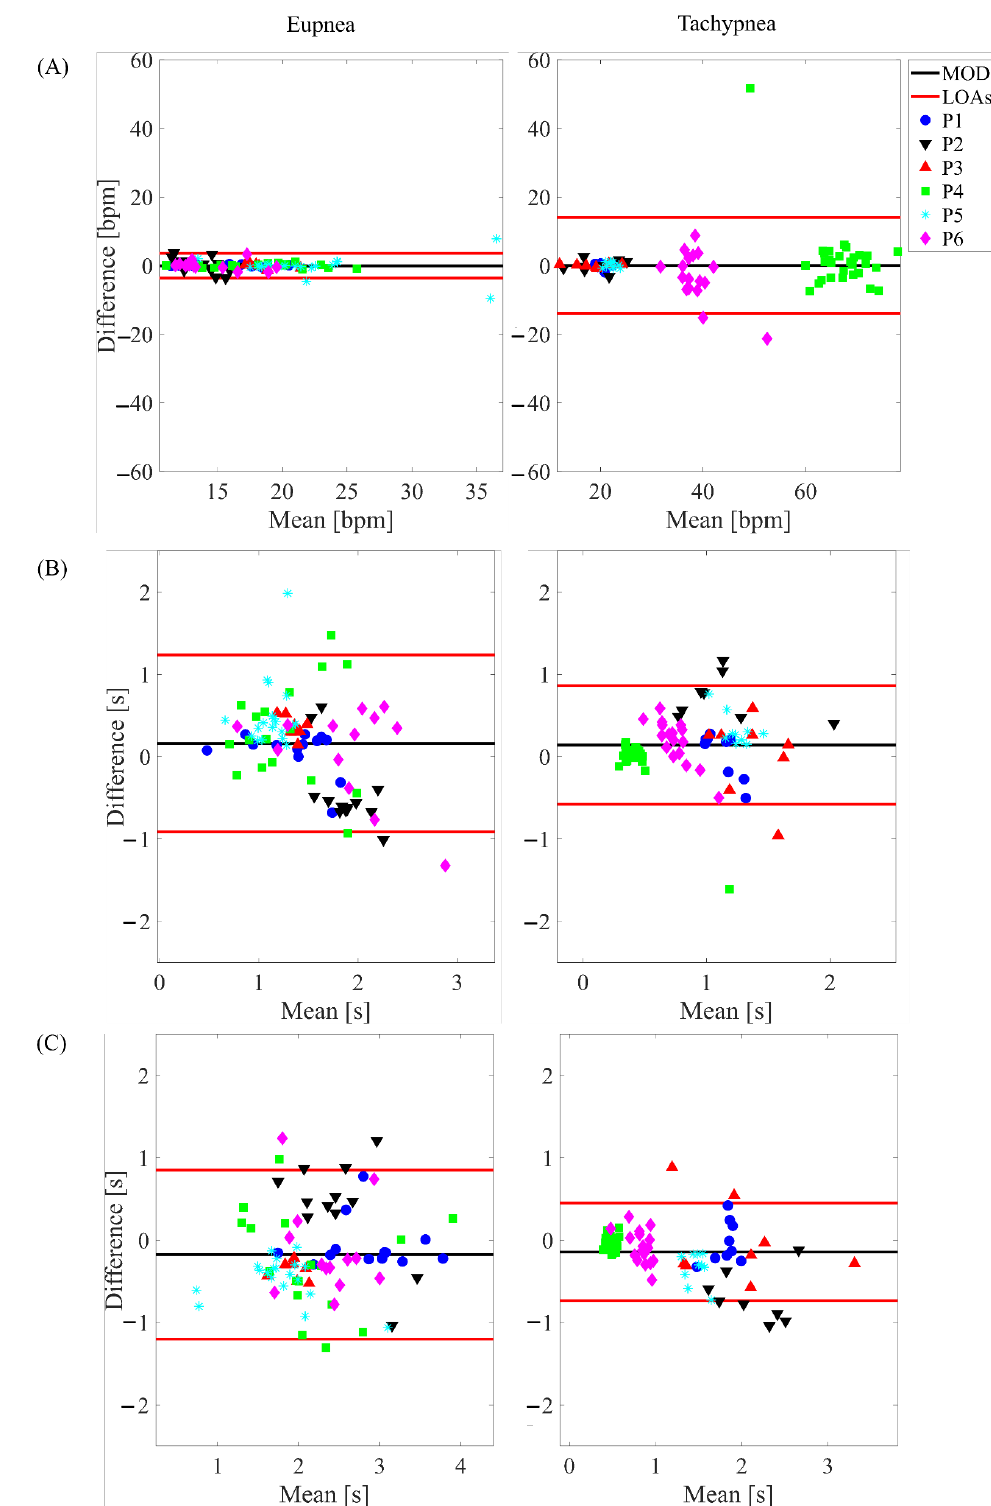
Figure 8. Bland-Altman plots depicting the estimated ( A ) f r , ( B ) t i and ( C ) t e on the respiratory signal retrieved from the affected side in eupnea and tachypnea